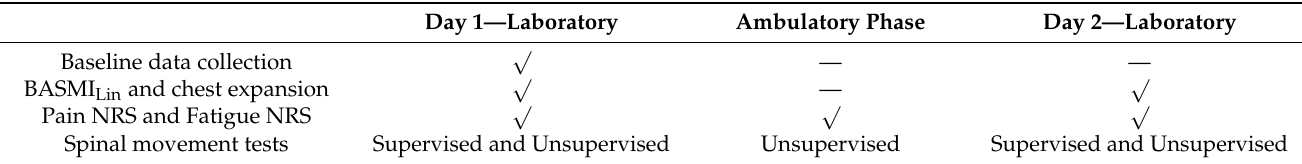
Table 1. Study assessment